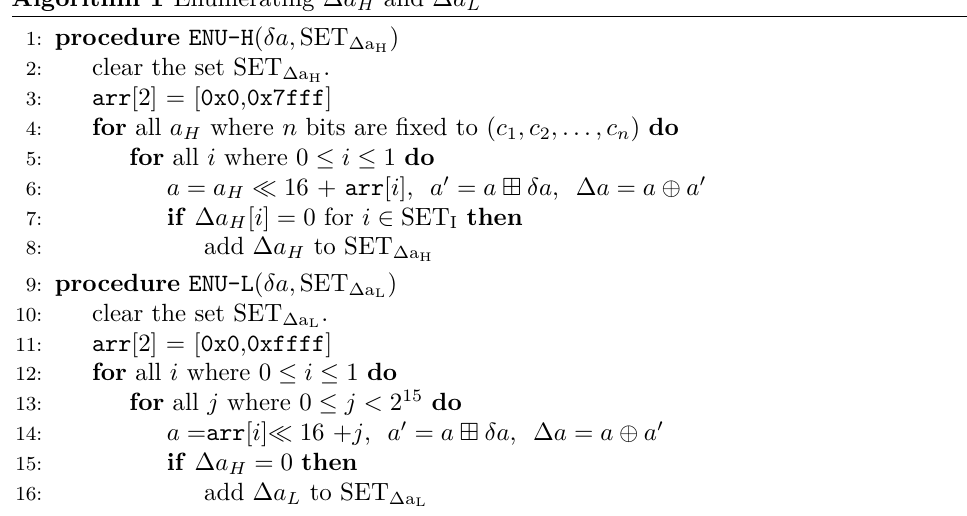
Algorithm 1 Enumerating ∆ a H and ∆ a